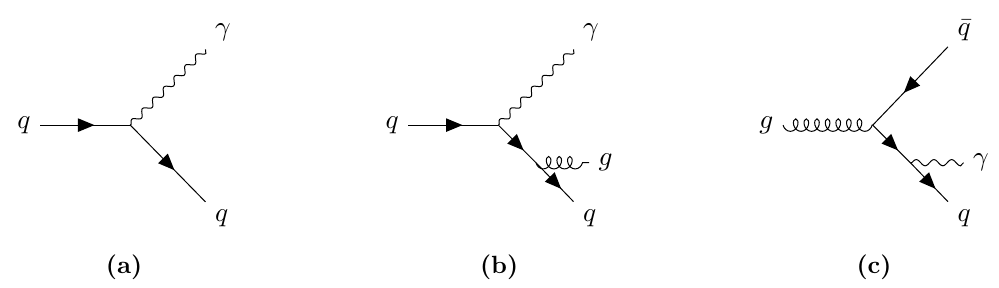
Figure 1. (a) Isolated photon subjet production from a quark at order (cid:11) distribution of this branching in the collinear limit is described by the QED splitting function P ( z ). (b, c) Processes that contribute to isolated photon subjet production at order (cid:11) e (cid:11) s . Of these, the initial quark term (b) dominates. Not shown are diagrams with a virtual gluon, which are accounted for using the plus